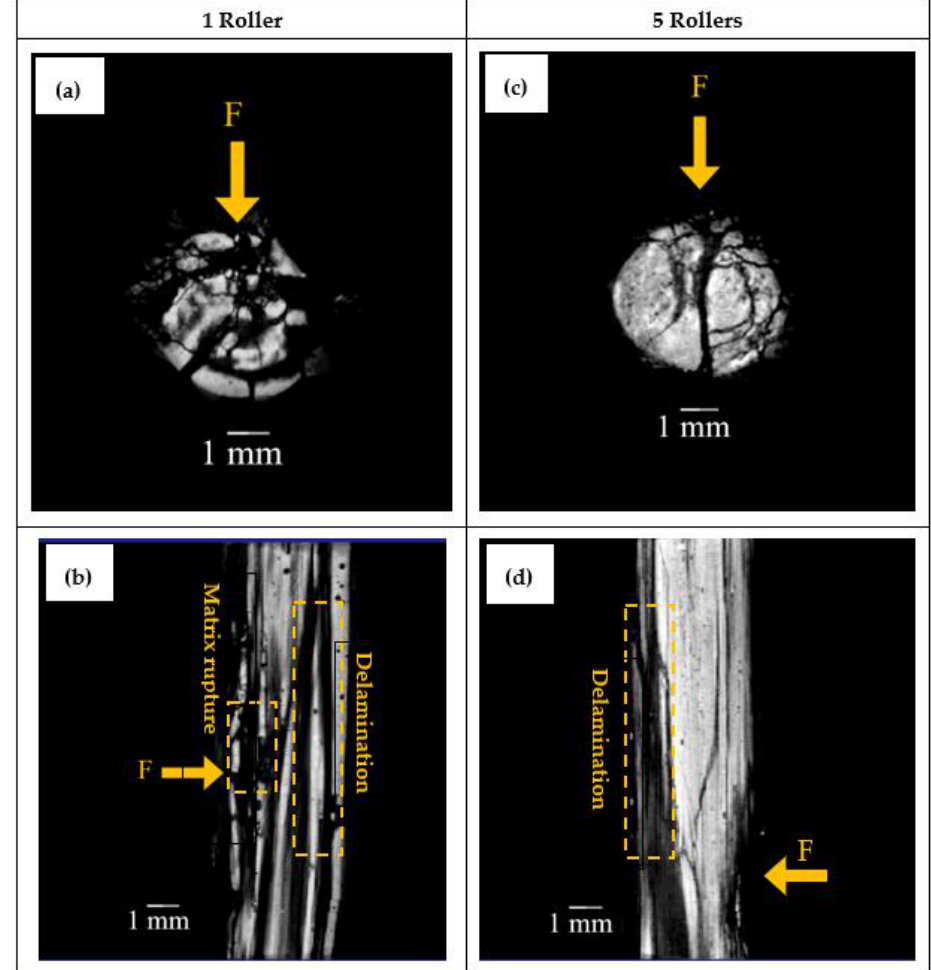
Figure 8. µ CT images of the typical failure mode of MCF produced with ( a , b ) one roller and ( c , d ) five rollers, as observed after bending tests. Orange arrows indicate the applied load direction during bending tests.